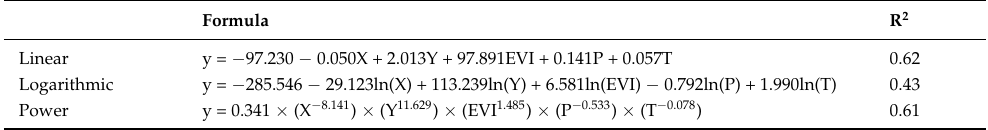
Table 6. Parametric regression models based on multiple factors.